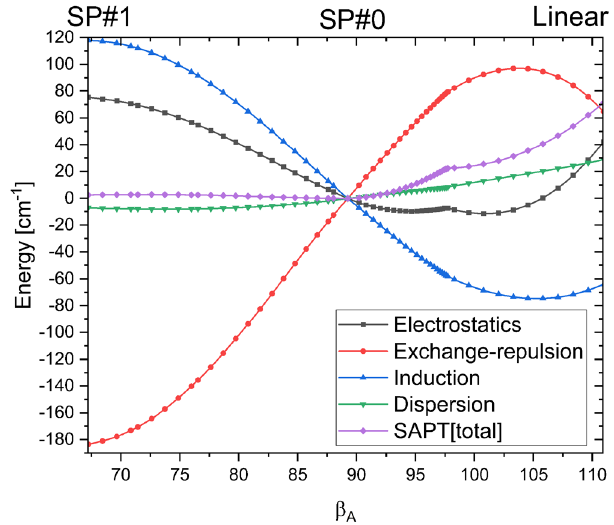
Fig. 3 Physical components of interaction energy. SAPT components, relative to their values at SP#0, along the path from SP#1 through SP#0 to the staggered linear hydrogen-bonded structure (see the discussion on the SAPT components in the Supplementary Information for more